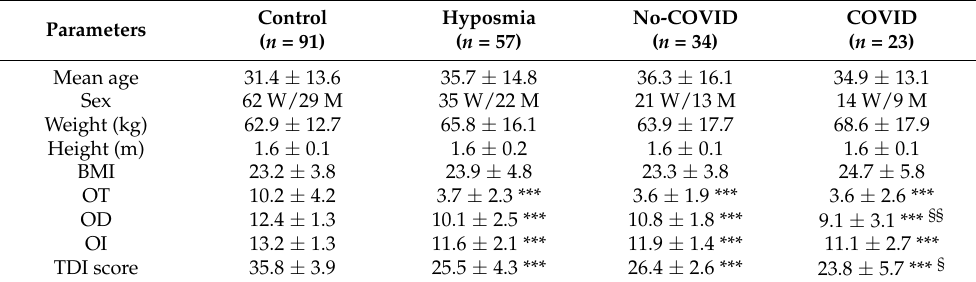
Table 2. Demographic and clinical features of total patients with hyposmia, patients with (COVID) or without (no-COVID) post-acute coronavirus syndrome, compared to healthy controls.